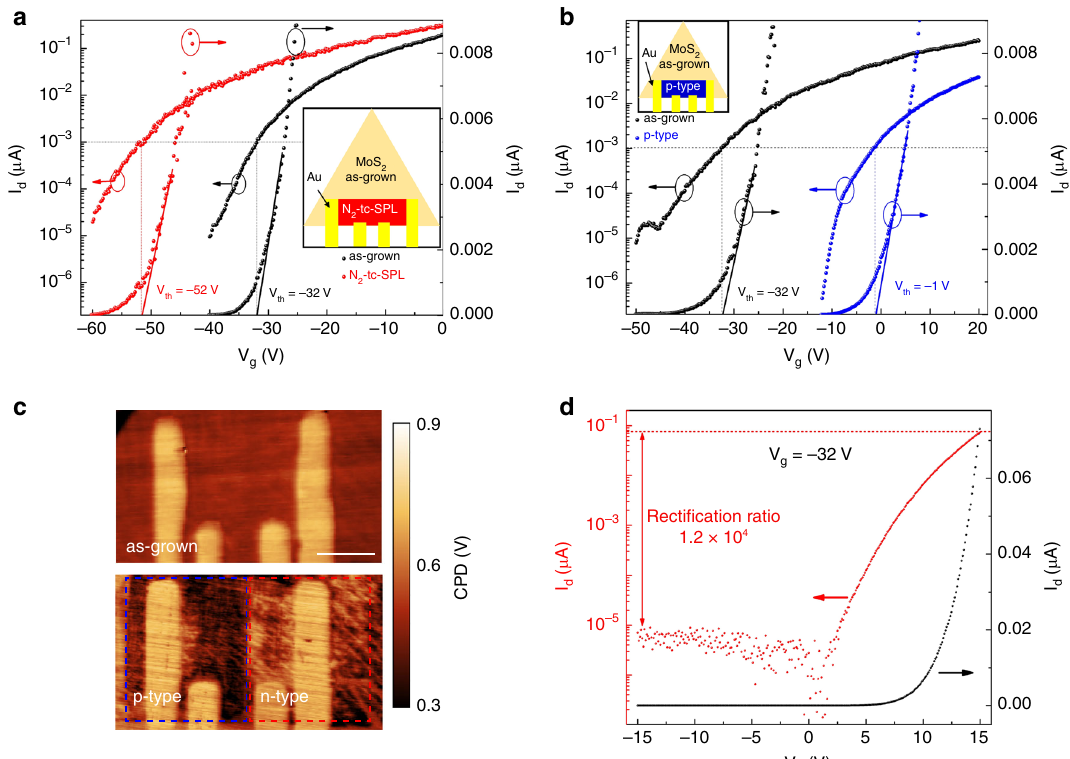
Fig. 6 Electrical characterization of tc-SPL doped FETs. a Transfer curves of a four-probe FET before (black curves) and after (red curves) N 2 -tc-SPL n- type doping of the full channel. Inset: schematic fi gure showing the FET with the whole channel being n-type doped by N 2 -tc-SPL. b Transfer curves of a four-probe FET before (black curves) and after (blue curves) tc-SPL p-type doping of the full channel. Inset: schematic fi gure showing the FET with the whole channel being p-type doped by tc-SPL. c KPFM images of a FET channel before (top panel) and after (bottom panel) the formation of the lateral p – n junction. Both the p-type half-channel (blue dashed box) and the n-type half-channel (red dashed box) are realized by using tc-SPL method. Scale bar: 2 μ m. d Output curve of the lateral p – n junction in logarithmic (left axis) and linear scale (right axis), obtained at the optimal back gating of − 32 V. A recti fi cation ratio >10 4 has been